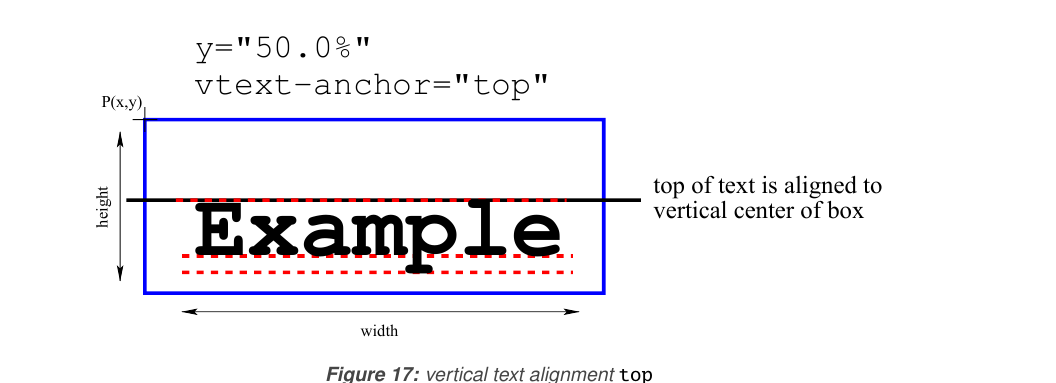
Figure 17: vertical text alignment top